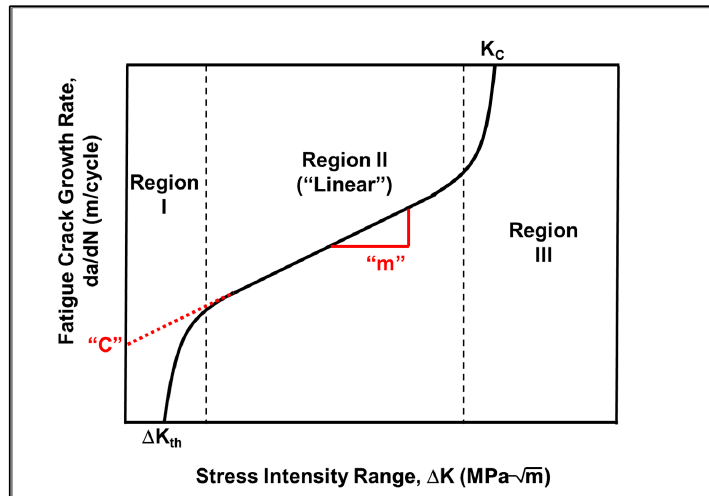
Figure 1. Fatigue Crack Growth Curve Schematic.